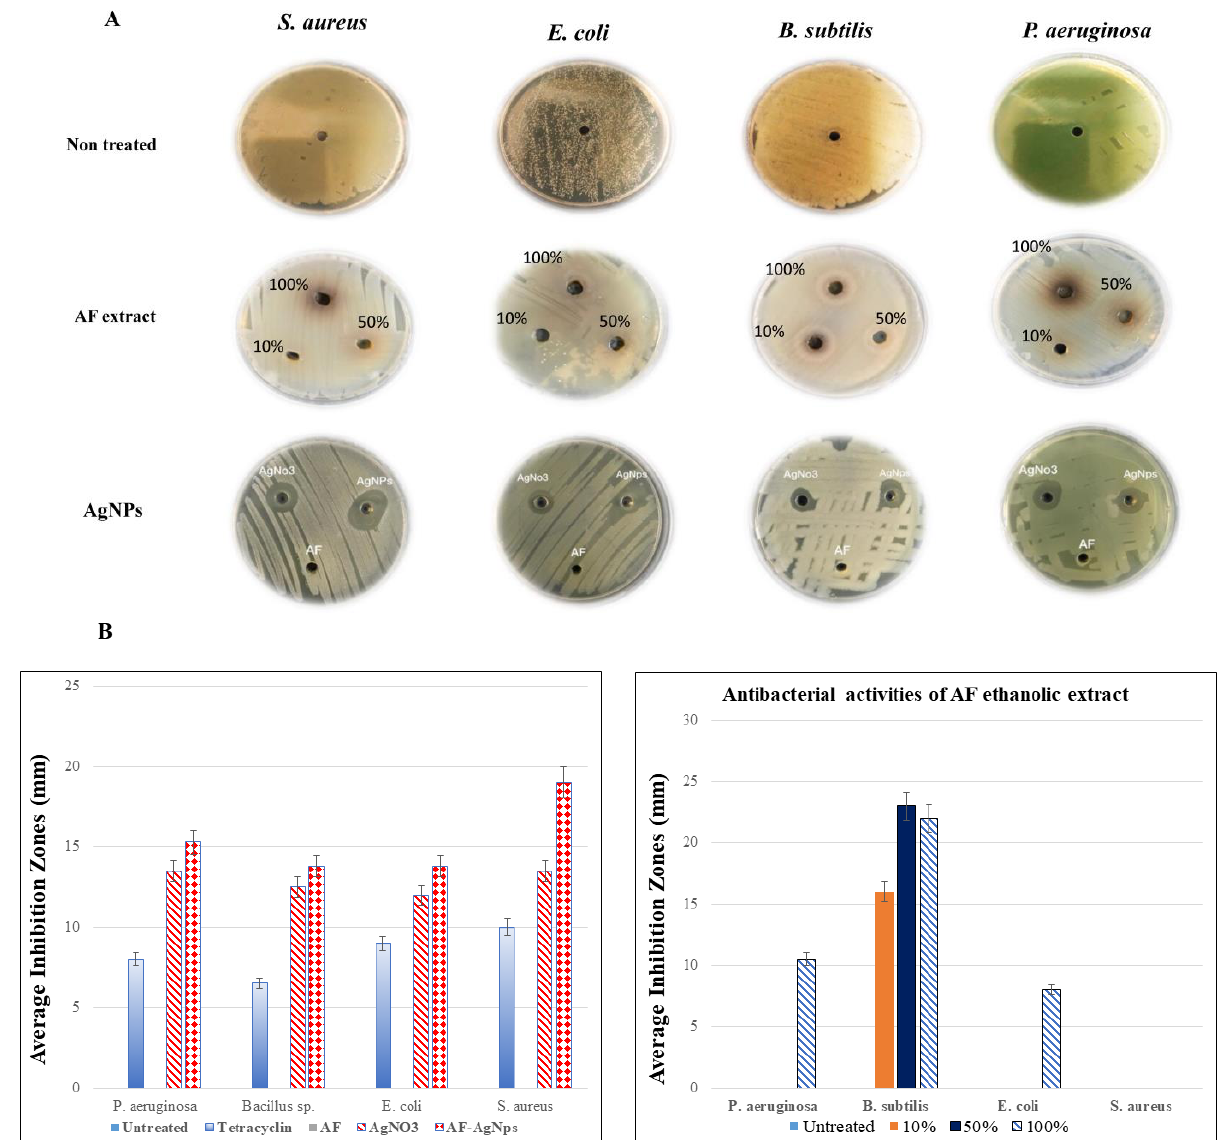
Figure 4. The antibacterial activity of A. factorovskyi extract and silver nanoparticles. The antibacterial activities of A. factorovskyi , Tetracycline, AF-AgNPs, and AgNO 3 were tested against different bacterial strains, ( A ) the antibiotic diffusion results, ( B ) the average inhibition zone in (mm) for the A. factorovskyi ethanolic extract (right), and nanoparticles (Left).